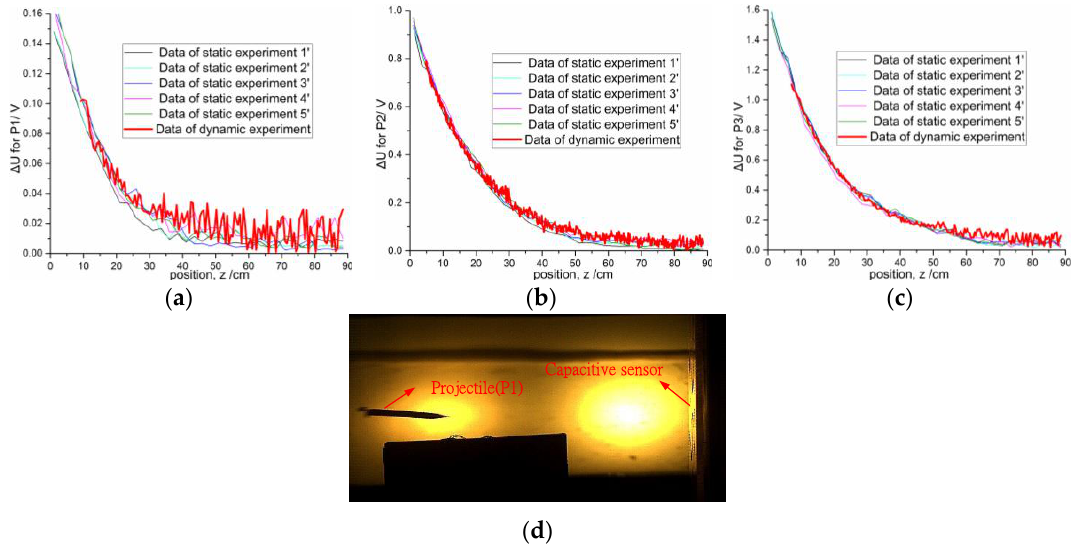
Figure 14. Comparisons of the static experiment data and the dynamic experiment data for three projectiles at the attack angle 90°: ( a ) P1; ( b ) P2; ( c ) P3; ( d ) Prototype of the dynamic experiment.